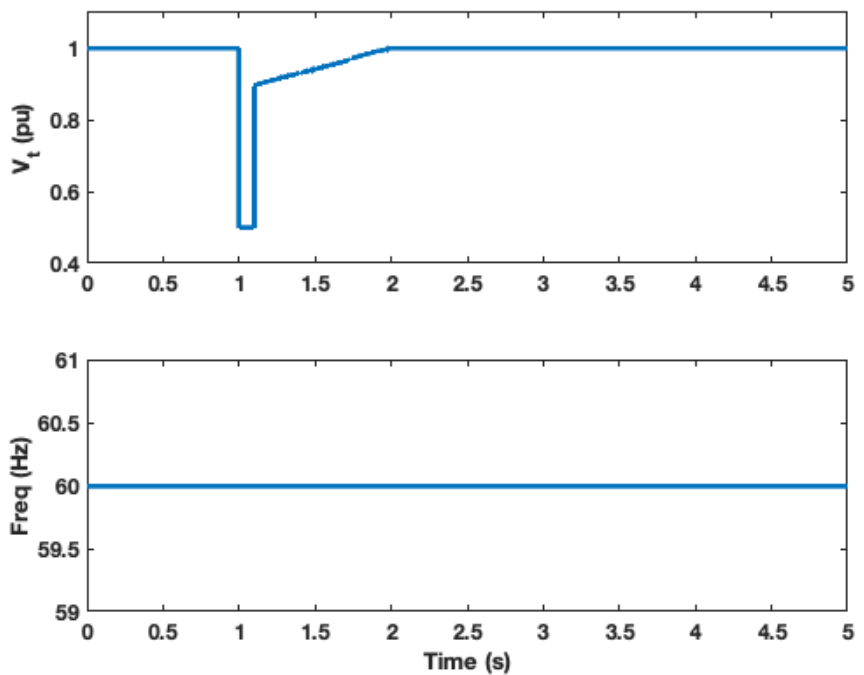
Figure 6. The input signals feeding the DER_A